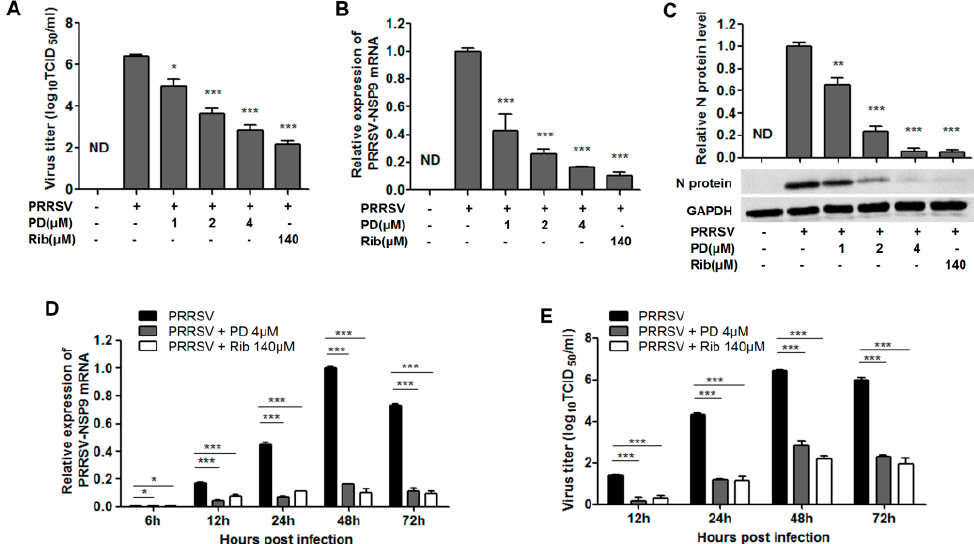
Figure 2. Confirming PD’s anti-PRRSV activity in PRRSV-infected MARC-145 cells. Cells grown in 6-well plates were infected with PRRSV GD-HD (0.05 MOI) for 2 h at 37°C and then cultured in fresh medium containing various concentrations of PD. At 48 h ( A , B and C ) or indicated time-points ( D and E ) post infection, the samples were subjected to viral titer, or RT-PCR, or Western blotting analysis. ( A and E ) The PRRSV titer was determined after treatment with PD for 48 h ( A ) or indicated time-points ( E ) using the end point dilution assay and expressed as log 10 TCID 50 /1 mL. ( B and D ) Relative PRRSV NSP9 mRNA level was analyzed using real-time RT-PCR at 48 h ( B ) or indicated time-points ( D ) after treatment with PD. Expression of GAPDH was shown as a loading control, and DMSO-treated sample (0 μ M PD) at 48 h was used as treatment (or solvent) control (set as 1). ( C ) Expression of viral N protein in cells treated with various concentrations of PD for 48 h was detected by Western blotting. Upper panel: the mean values from three independent experiments. Lower panel: one representative Western blotting image out of three independent experiments. Results shown in upper panel of C are normalized N protein levels based on the optical densities (OD) of the bands from three independent experiments. Software Image J was used